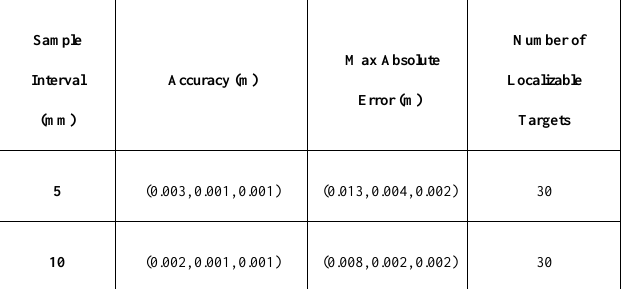
Table 1. The target localization accuracy using Cyclone Sample